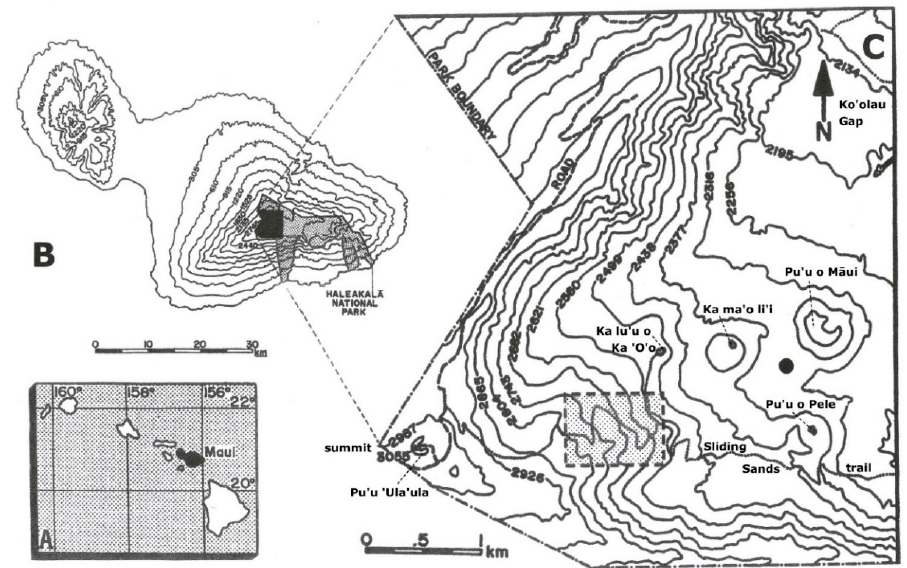
Figure 2. Location of the study area. ( A ) Hawaiian archipelago; island of Maui is shaded black. Latitude (N) and longitude (W) are indicated. ( B ) Maui. Scale in km, elevations in m; contour interval is ~305 m (=1000 feet). Stippled area in east Maui shows current extent of Haleakal ā National Park. ( C ) Western portion of Haleakal ā crater; stippled rectangle indicates main study site on the inner crater wall, dark dot shows location of thermograph monitoring. Cinder cones and the Sliding Sands hiking trail are indicated. Scale in km, elevations in m; contour interval is 61 m (=200 feet). Base map: USGS, State of Hawai’i, Principal Islands, 1971, scale 1:500,000.